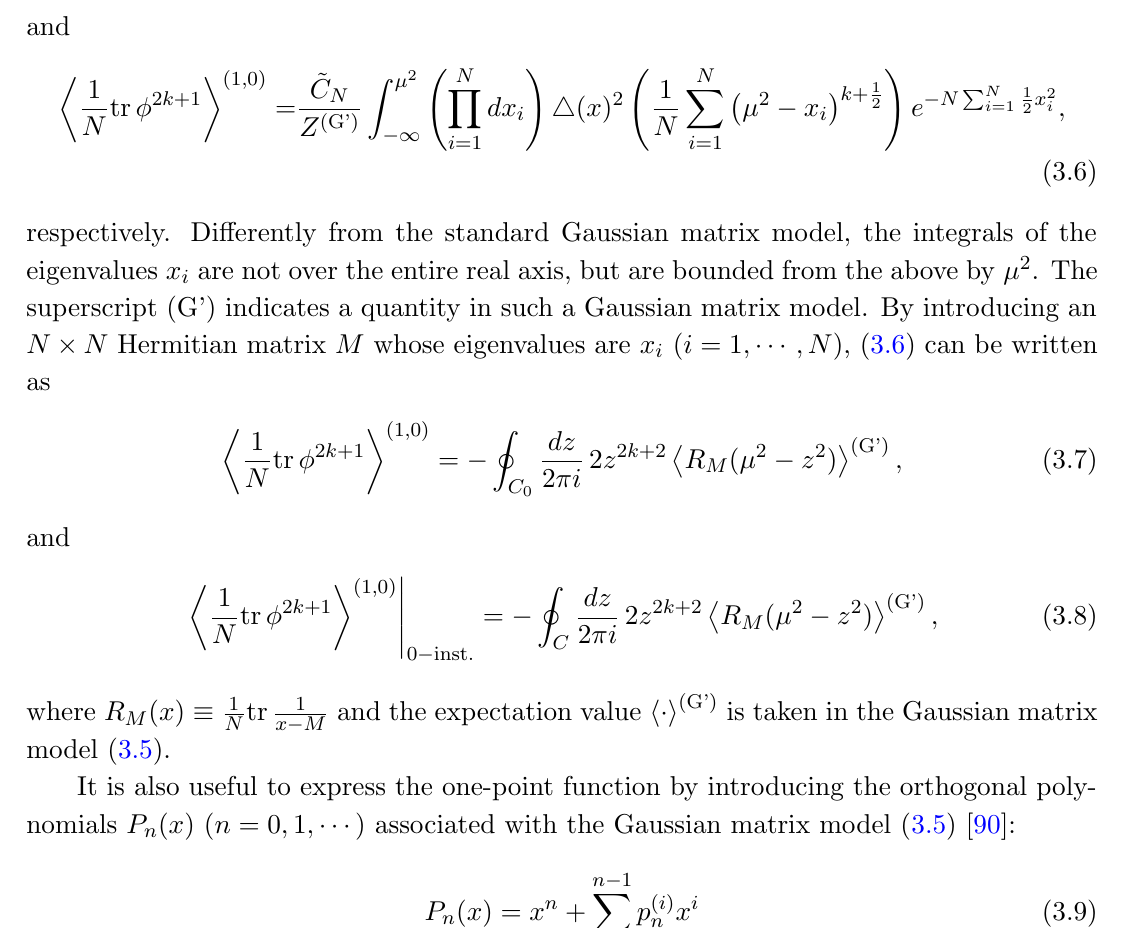
Figure 1 . Integration contour C on the complex z